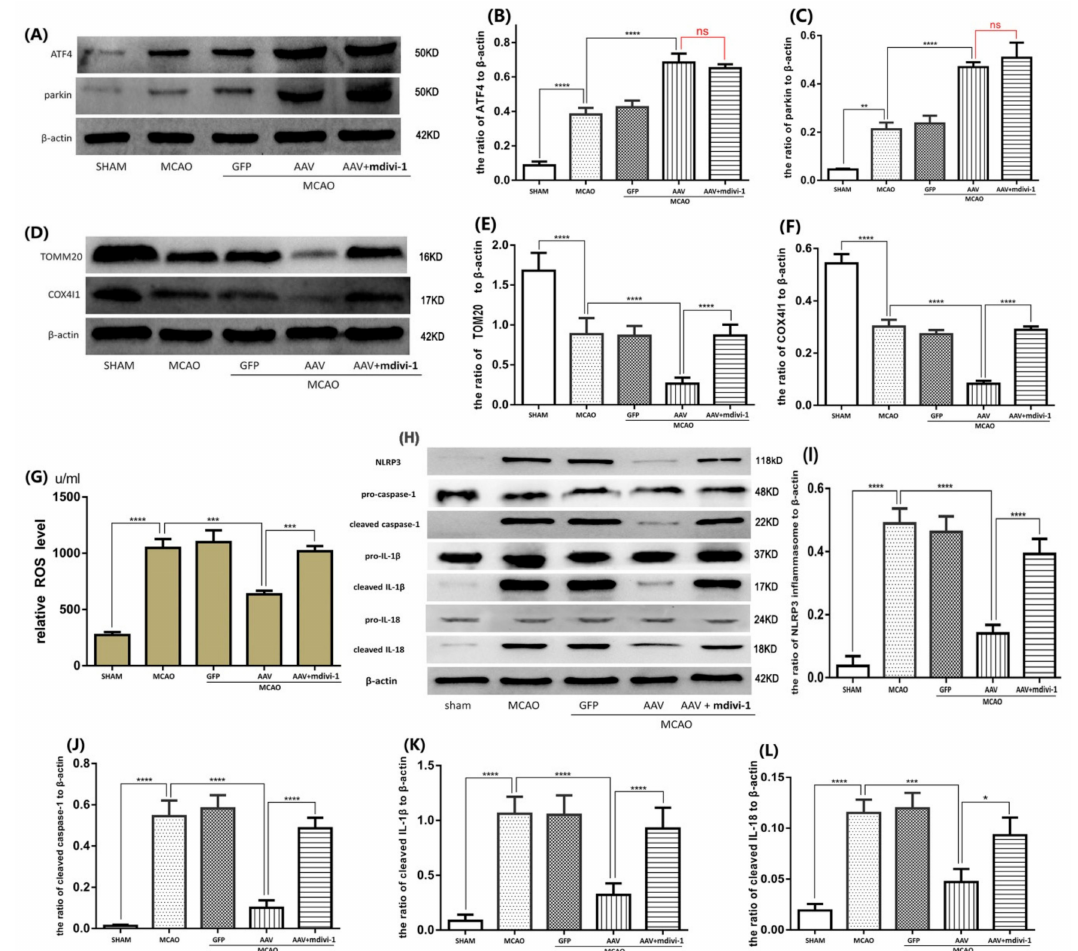
Figure 7. Mdivi-1 treatment impaired the e ff ects of ATF4 on mitophagy activity and NLRP3 inflammasome activation. ( A – C ) No di ff erences were observed in terms of ATF4 and parkin expression between the AAV + MCAO group and the mdivi-1 + AAV + MCAO group. Mdivi-1 treatment significantly impaired the inhibitory e ff ects of ATF4 on TOM20 and COX4I1 expressions ( D – F ), NLRP3 inflammasome activation ( H – L ) and ROS production ( G ). Error bars represent mean ± SD. (* p < 0.05, ** p < 0.01, *** p < 0.001 and **** p < 0.0001 vs. indicated group). n = 5 in each group. MCAO, middle cerebral artery occlusion-reperfusion; GFP, green fluorescent protein; AAV, ATF4 overexpression adeno-associated virus; siRNA, small interfering RNA; mdivi-1, mitochondrial division